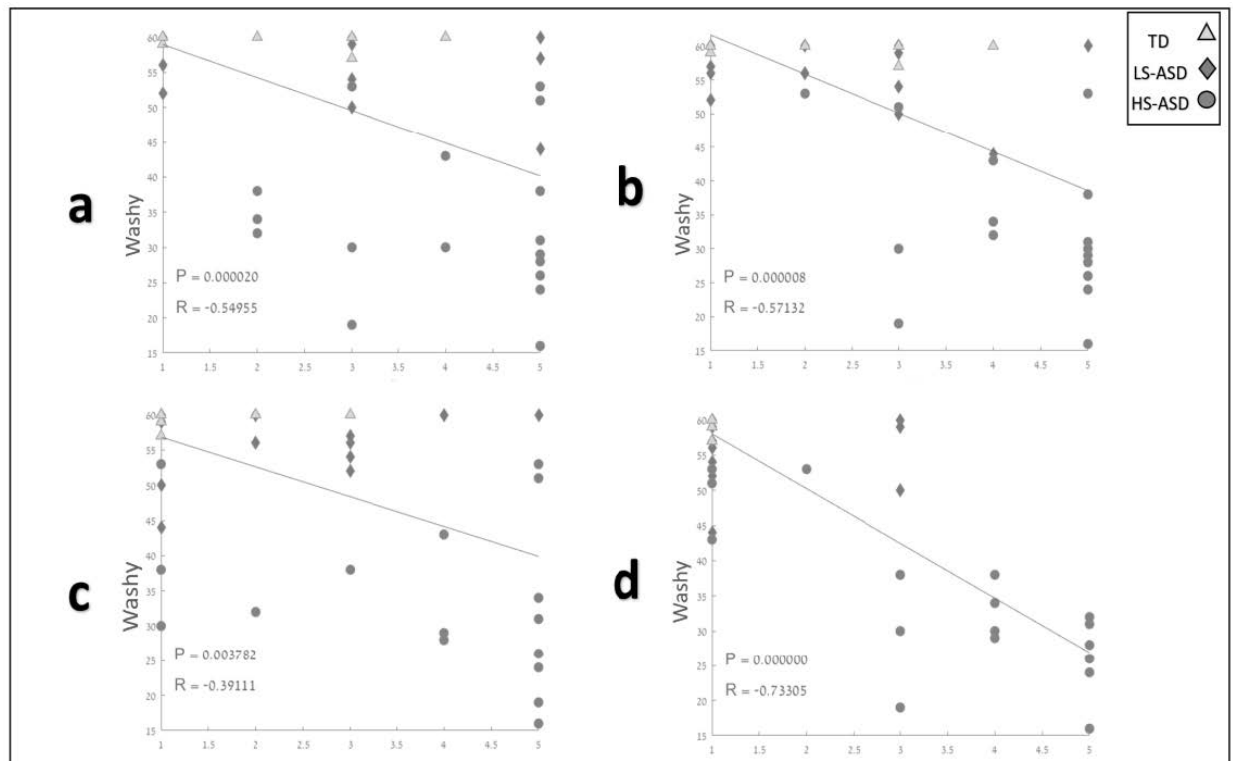
Figure 2. Correlations between Washy and Participation in Childhood Occupation (PICO-Q) per- formance measures across experiment groups. Note. The relationship between Washy and PICO-Q scores is illustrated using Spearman’s rank correlation coefficient tests of individuals’ Washy’s per- formance score against their PICO-Q difficulty scores item, including ( a ) PICO-Q-1, ( b ), PICO-Q-2, ( c ) PICO-Q-4, ( d ) and PICO-Q-16. The participants with typical development (TD; triangles) usually received the lowest scores in both assessments, followed by participants with LS-ASD (diamonds), and ending with participants with HS-ASD (circles), who received the highest (worst) scores in both assessments.